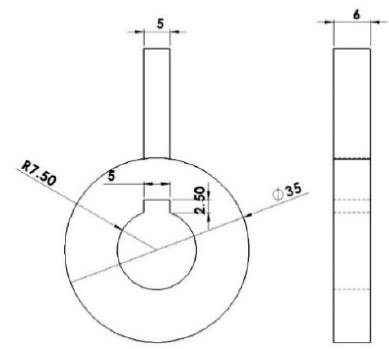
Figure 2. Disk designed to determine the material wear.